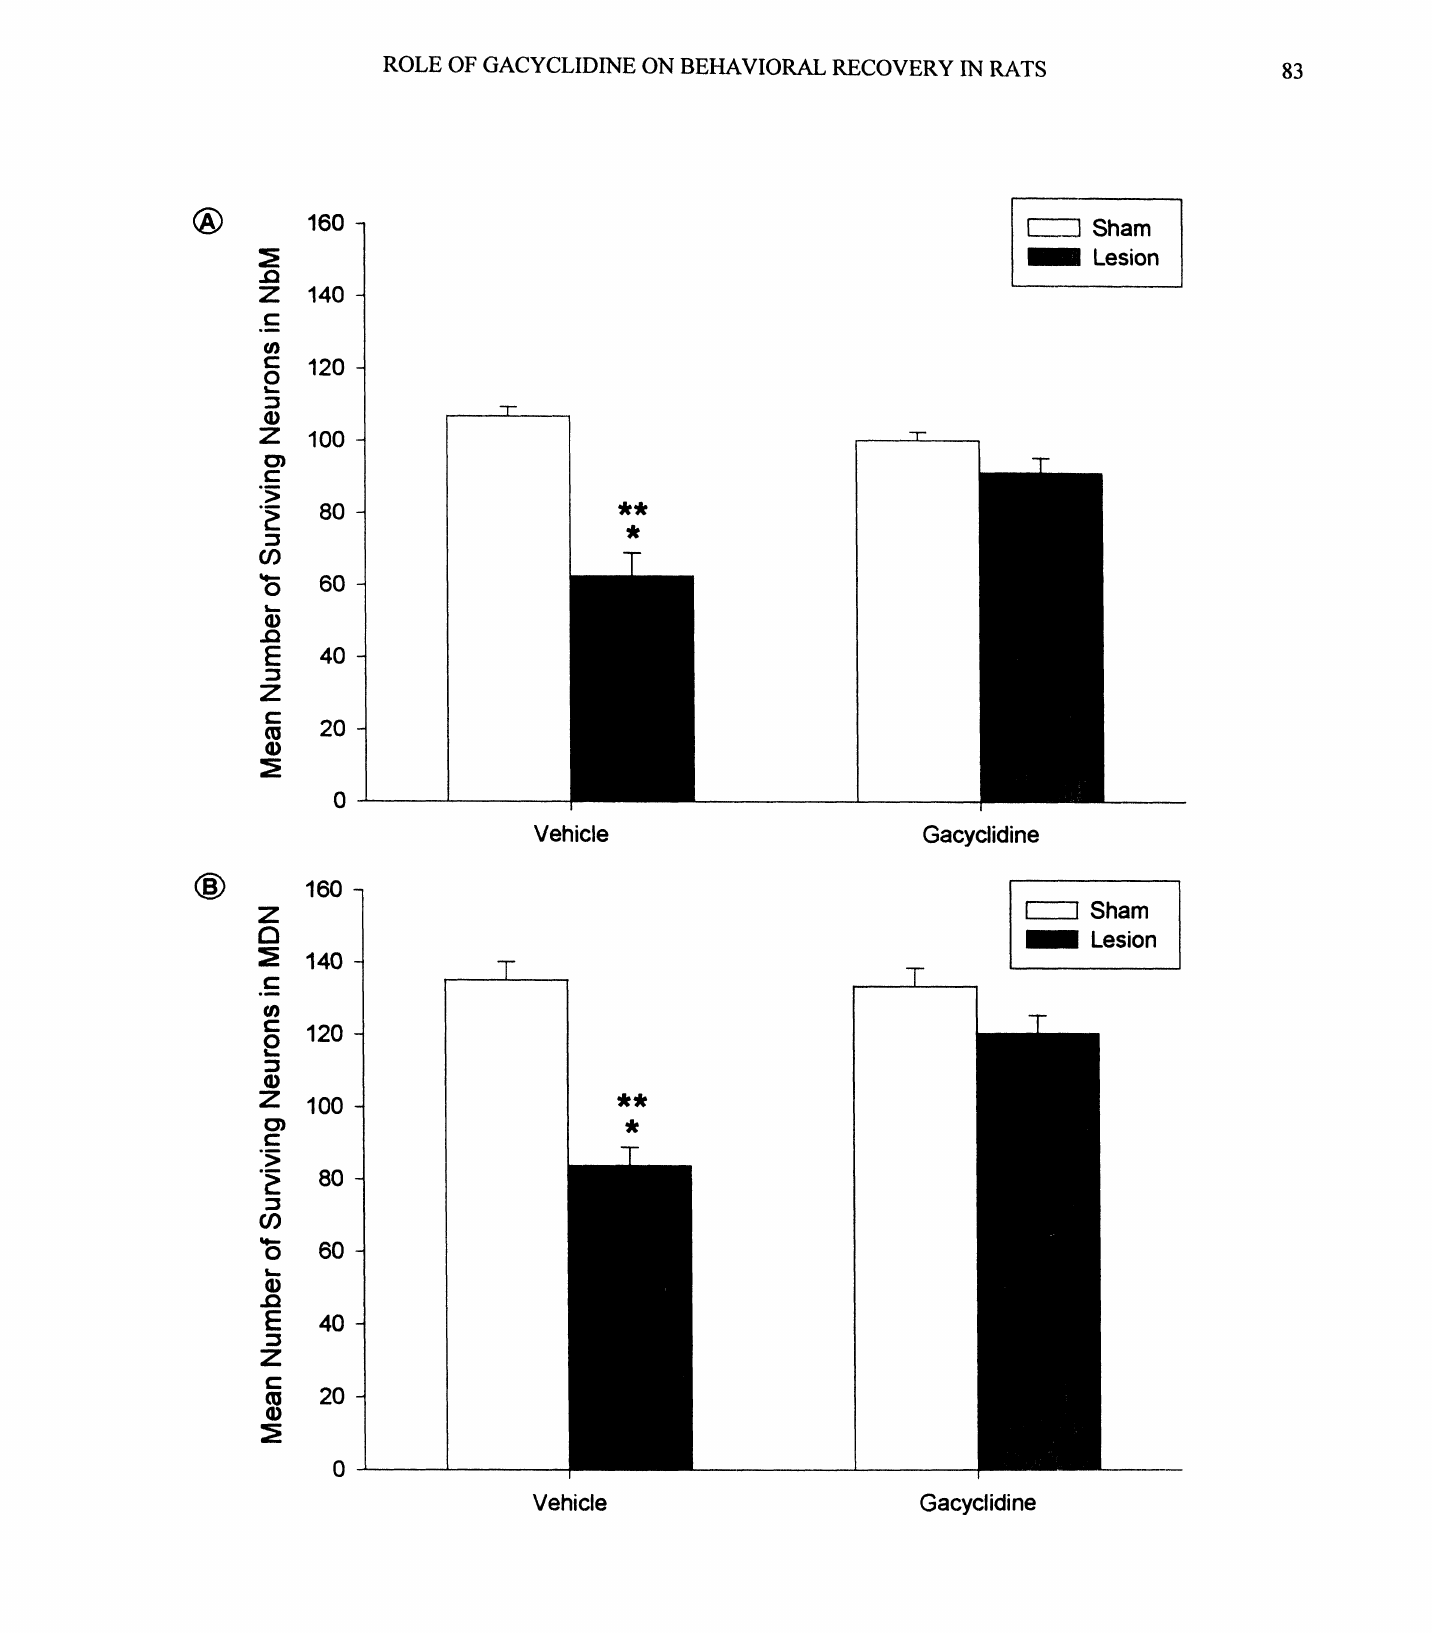
Fig. 6: (a) Number of surviving neurons in the NBM (*=p<0.05). Animals treated with 0.1 mg/kg of gacyclidine had more surviving neurons than their vehicle-treated counterparts (**=p<0.05). (b) After cortical contusions, a reduction was seen in the number of surviving neurons in the MDN (*=p<0.05). Animals given 0.1 mg/kg gacyclidine, however, had more surviving neurons than their vehicle treated counterparts